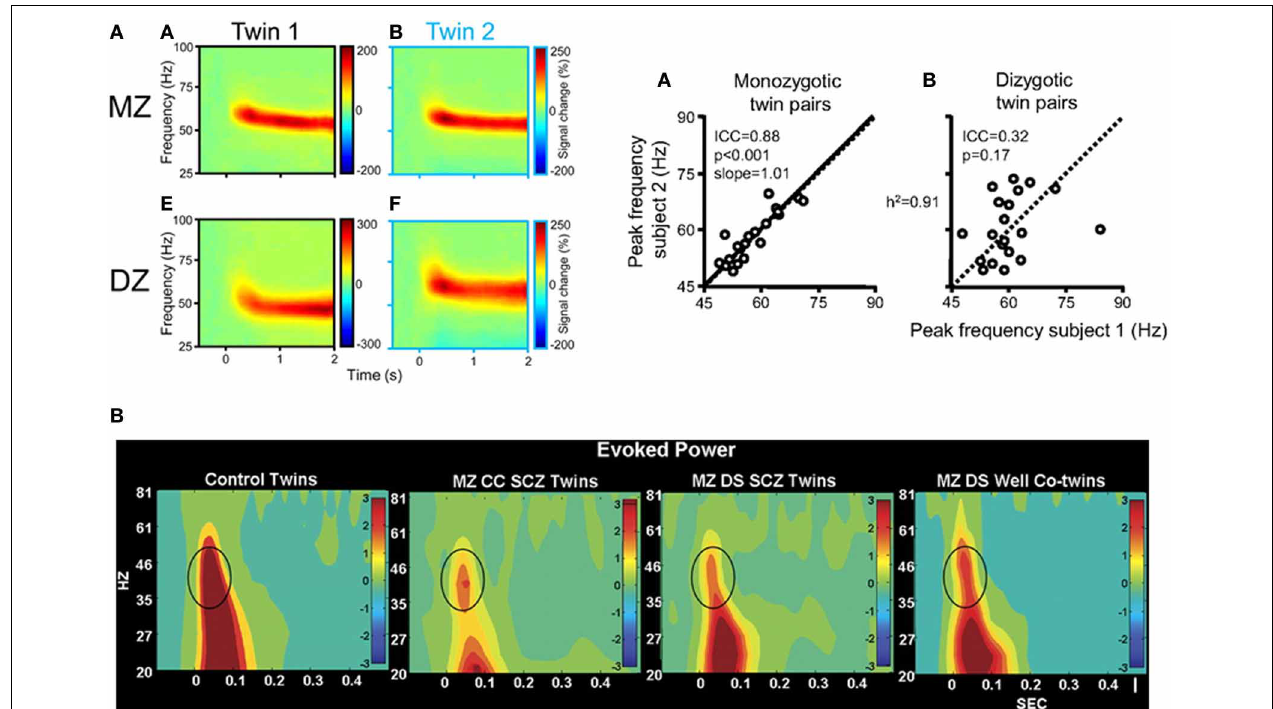
FIGURE 2 | (A) Left: visually induced gamma-band activity in MEG data in a monozygotic (MZ) and a dyzygotic (DZ) twin pair. Time-frequency representations (TFRs) of activity in the gamma-band range relative to prestimulus baseline levels in two twins of a MZ pair, averaged across 74 parieto-occipital MEG sensors. Time 0s denotes stimulus onset. Right: correlation between gamma-peak frequencies in MZ twins [A] and DZ twins [B]. Each data point represents the peak frequency of one twin vs. that of his or her co-twin (random axis assignment). Slope values are estimated by random permutations of x and y values. The data suggest a heritability of the gamma-band frequency of 91%. Adapted from van Pelt et al. (2012).